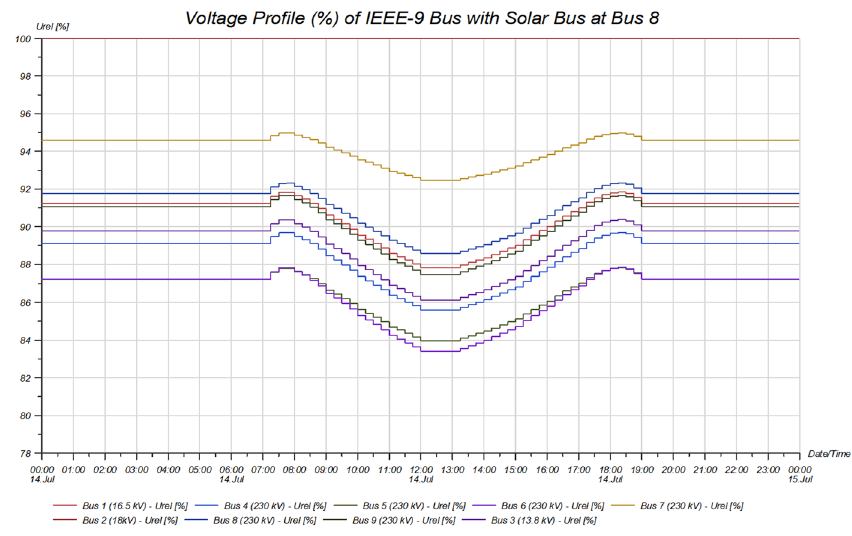
Fig. 13 Voltage profile of IEEE-9 bus with solar bus (without volt-var) function